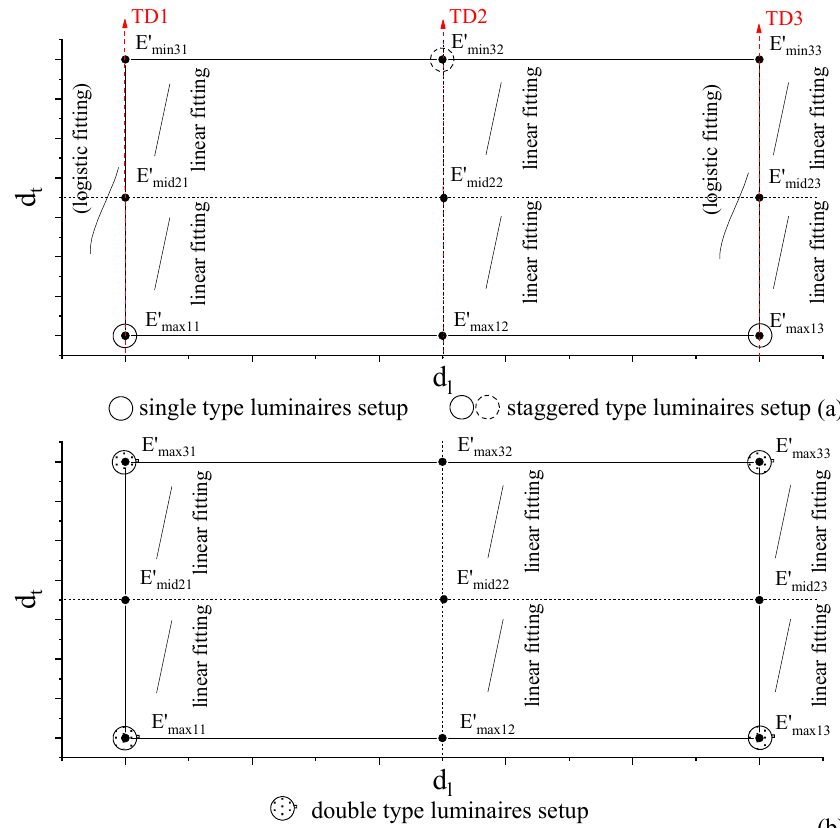
Figure 9. Illuminance modelling using logistic/linear functions with feature points in the transverse direction of single type, staggered type, and double type. ( a ) Logistic/linear fittings are applied for single- and staggered-type luminaires setup between two luminaires. ( b ) Linear fittings are applied for double-type luminaires setup between two luminaires. TD1: Transverse Direction No. 1, TD2: Transverse Direction No. 2, TD3: Transverse Direction No. 3. The feature points with the same rank numbers correspond to those in Figure 4. TD1 and TD3 are perpendicular to the luminaires direction. TD2 is in the middle for the single and double types, and perpendicular to the luminaires for the staggered type.